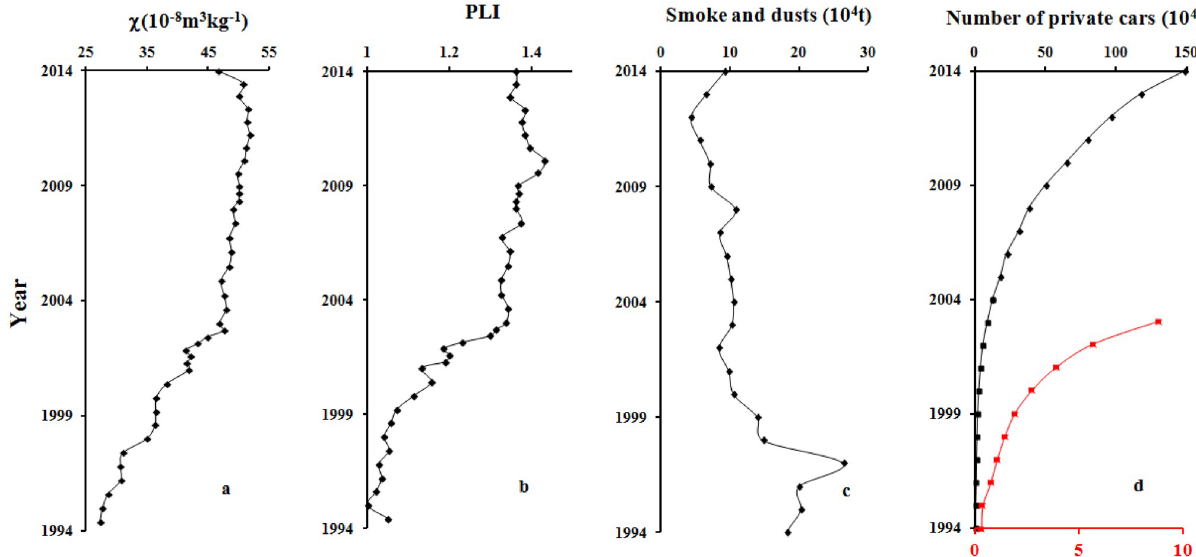
Fig 6. Variations in χ (a) and the PLI (b) in core QH1. Variations in annual smoke/dust emissions (c) and the number of private cars in Nanjing City (d) from 1994 to 2014 (the red line indicates the number of private cars from 1994 to 2003).